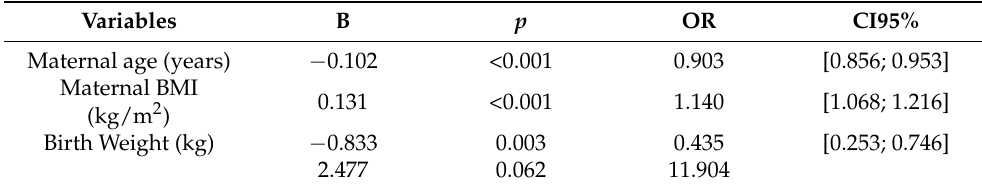
Table 2. The regression coefficients for maternal age, maternal BMI, and weight at birth. Variables B